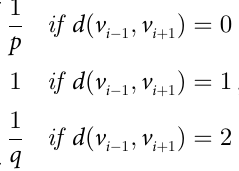
Fig 3. Meteorological data in Guangzhou City. (A) Weekly mean temperature of an arbitrarily selected township from January 2015 to September 2019. (B) Weekly cumulative rainfall of an arbitrarily selected township from January 2015 to September 2019. (C) Weekly mean temperature and (D) weekly cumulative rainfall of all townships within the city during the week of September 12–18, 2016.